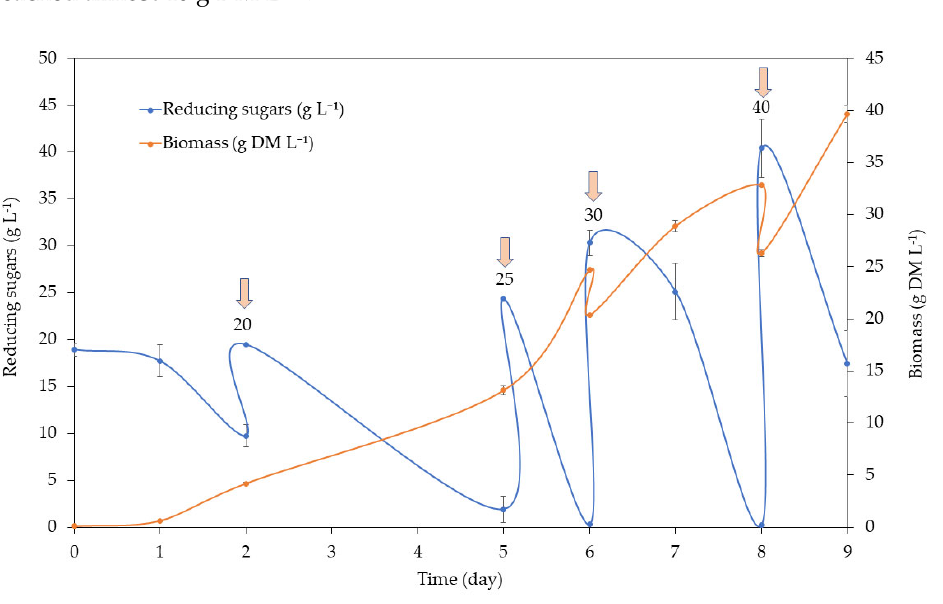
Figure 3. Reducing sugar consumption expressed as g L − 1 of glucose in the reactor (before and after adding fresh medium) and biomass production (g DM L − 1 ) through the fermentation days using modified Bristol medium.